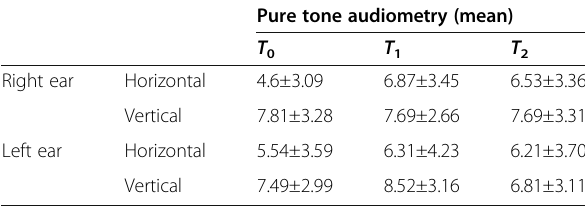
Table 2 Mean PTA during the time according to the type of deformity and movements in the right and left